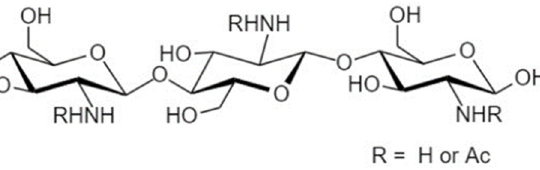
Figure 6. COS structure: the main components of COS are 1,4-linked GlcNAc and 1,4-linked GlcN. COS, chitin/chitosan-oligosaccharides.